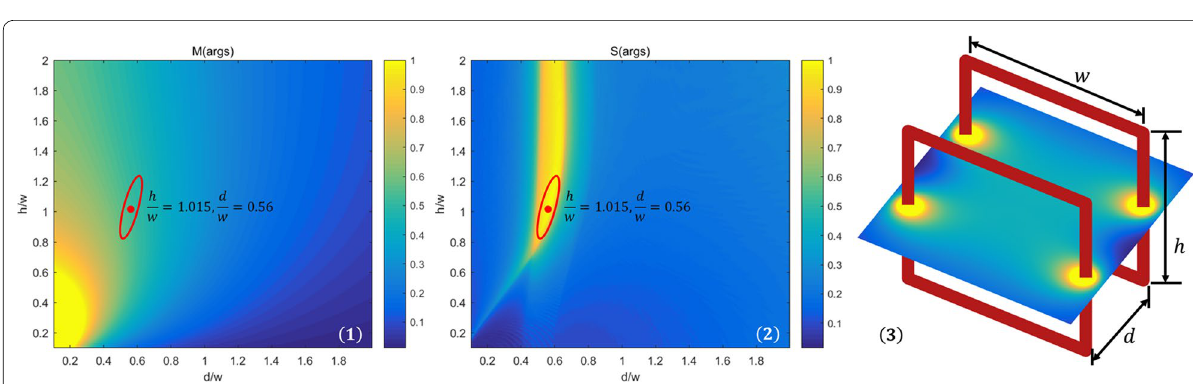
Figure 12 Optimization result for the rectangle-shaped coil pair inducing uniform magnetic